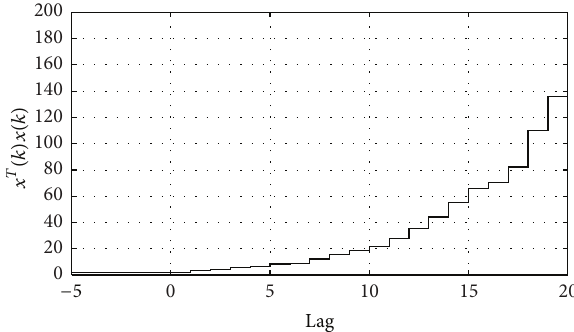
Figure 5: The norm of initial state responses of system (60).